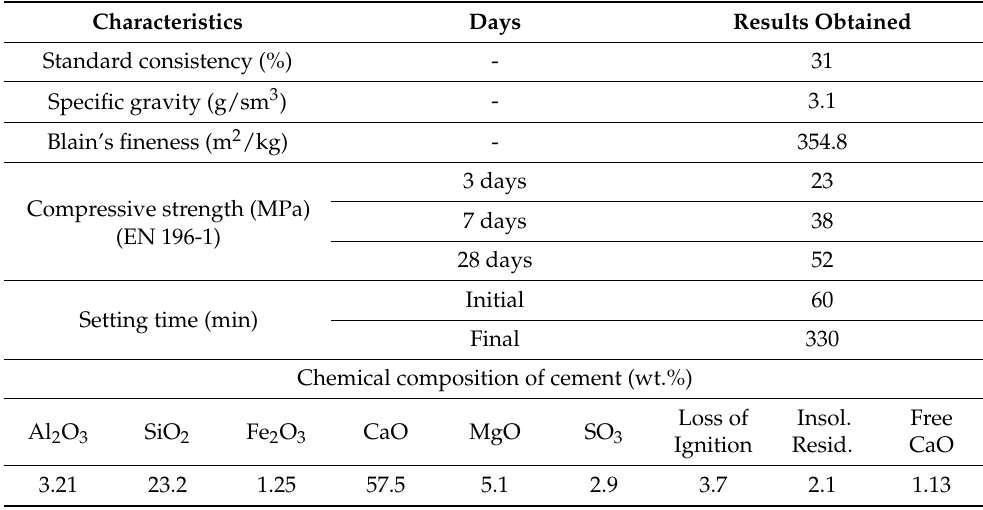
Table 1. Physical properties and chemical composition of cement. Characteristics Days Results Obtained Standard consistency (%)